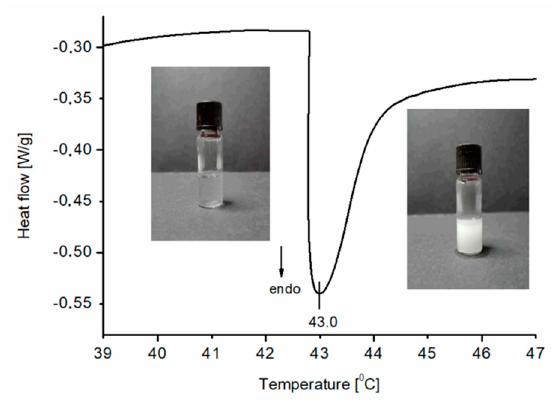
Figure 5. The heating DSC thermogram for an aqueous solution of P1 (1.5% w / w ) and photos of the solution below and above the phase transition corresponding to the endothermic effect visible on the curve. The heating rate of 1 K/min.